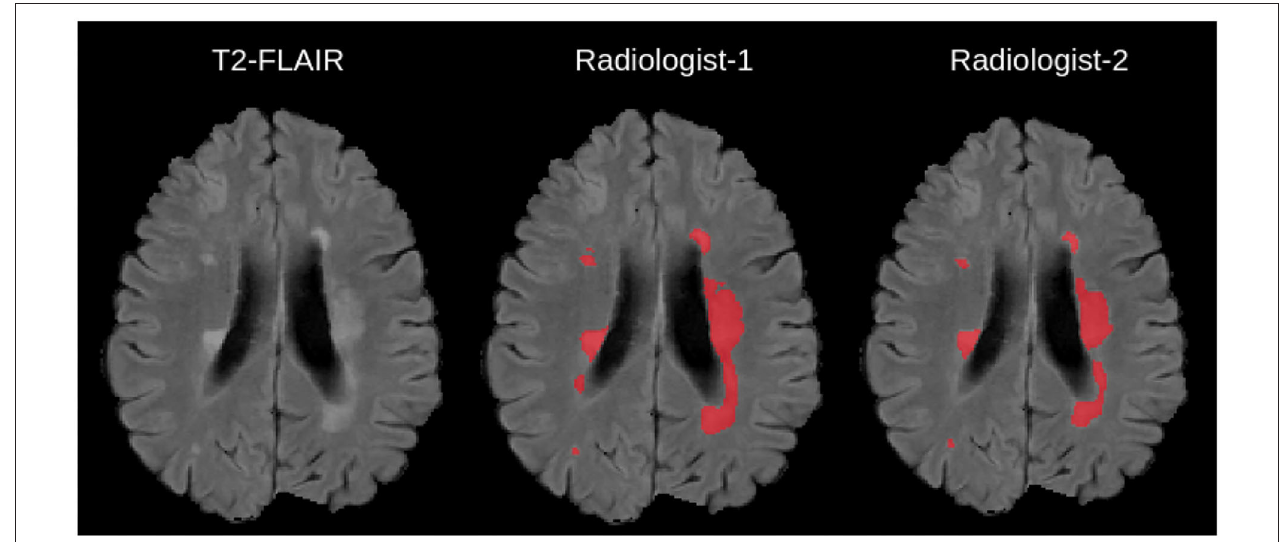
FIGURE 1 | Example Illustration of Multiple Sclerosis lesions overlaid on a 2-D T2-FLAIR scan, together with manual delineations from independent experts taken from (